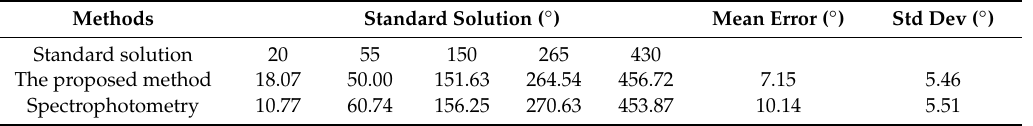
Table 2. Comparison of measurement results by two methods.